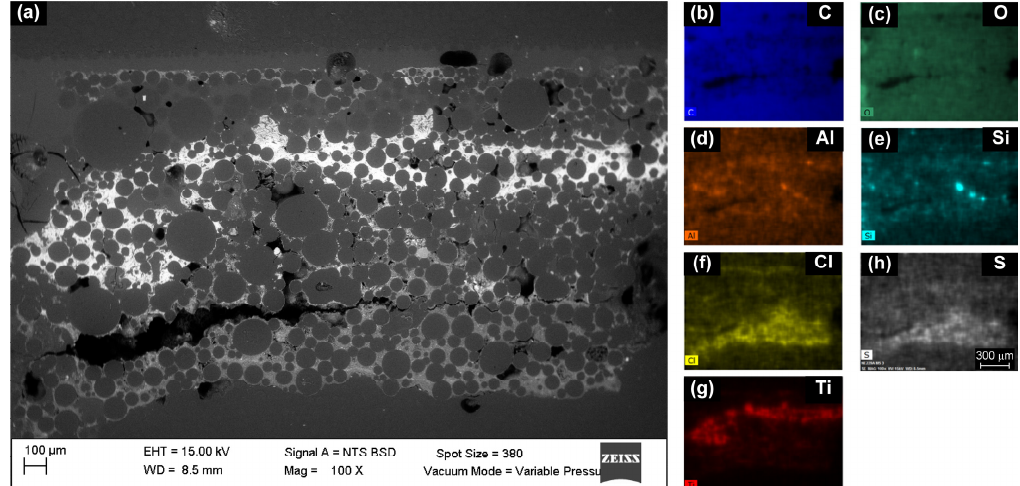
Figure 3. ( a ) SEM micrograph (BSE, 15.0 kV, 100×, area studied approximately 3000 × 1800 microns). Elemental mappings (EDS, 15.0 kV, 100×) of predominant elements: ( b ) C, ( c ) O, ( d ) Al, ( e ) Si, ( f ) Ti, ( g ) Cl and ( h ) S.